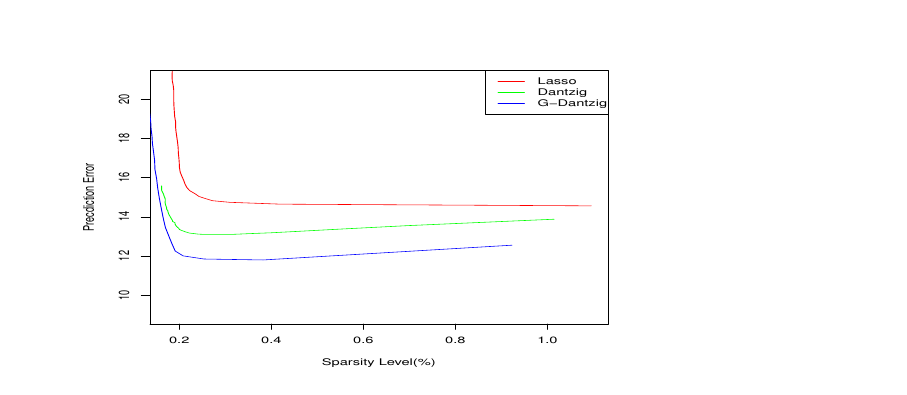
Figure 1. Prediction errors in stock prices plotted against the sparsity of the estimated transition matrix. Table 1. Comparison of estimation errors of three methods under different setups. The standard deviations are shown